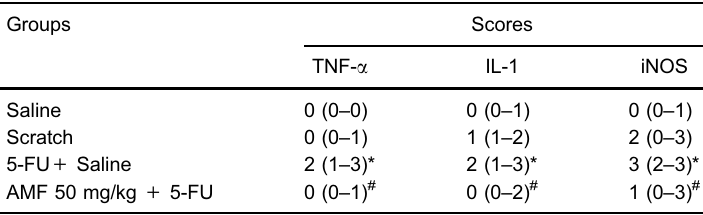
Data are reported as median and range of six samples. *P o 0.05 vs saline group. # P o 0.05 vs 5-FU group. Data were analyzed by Kruskal-Wallis and Dunn ’ s tests. 5-FU: 5- fl uorouracil; AMF: